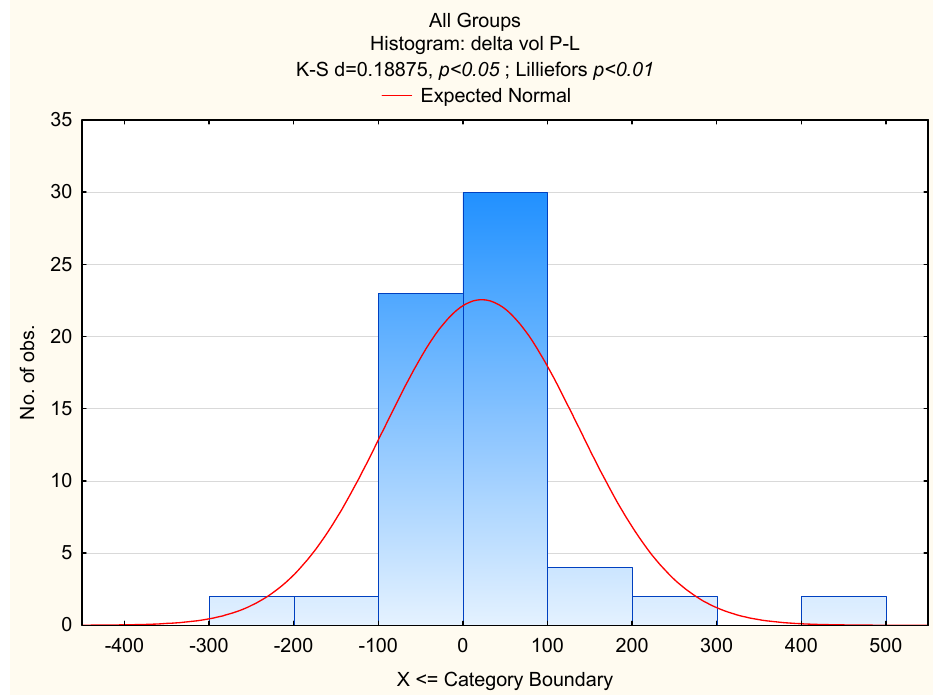
Figure 2. Breast volume fluctuating asymmetry in women with different breast sizes. All Groups Histogram: ln delta vol unsigned